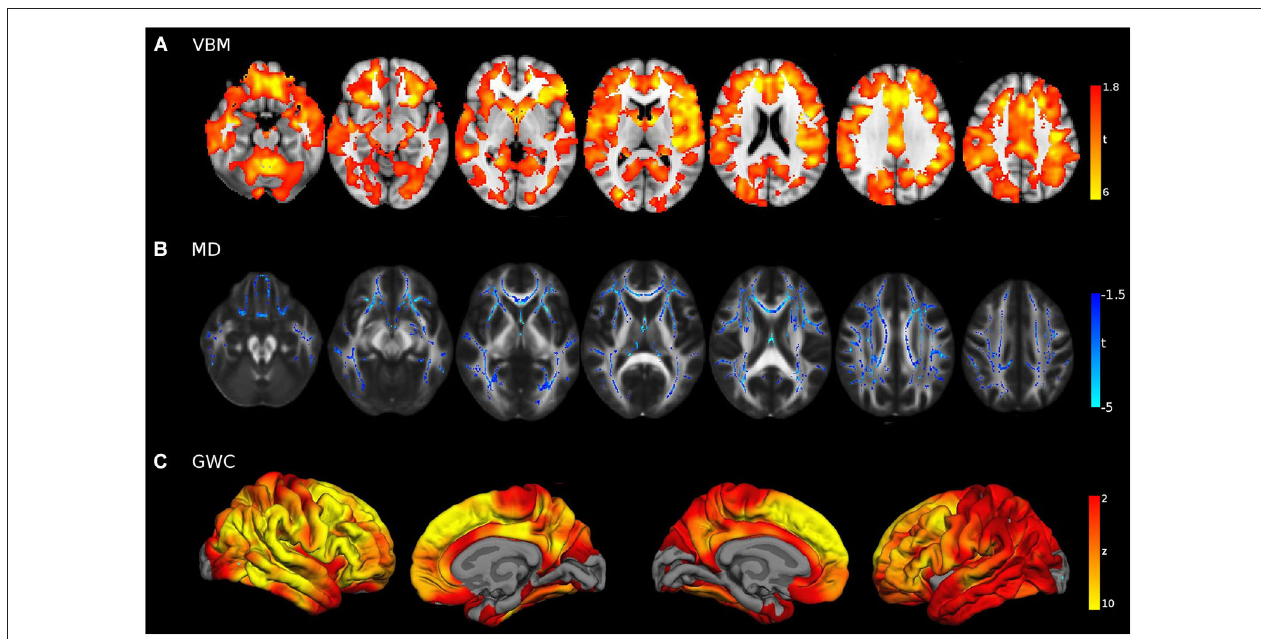
that survived multiple corrections. Bilateral medial and lateral surfaces are displayed in GWC while axial slices ( z = [ − 20:40:10]) are displayed both for VBM and MD